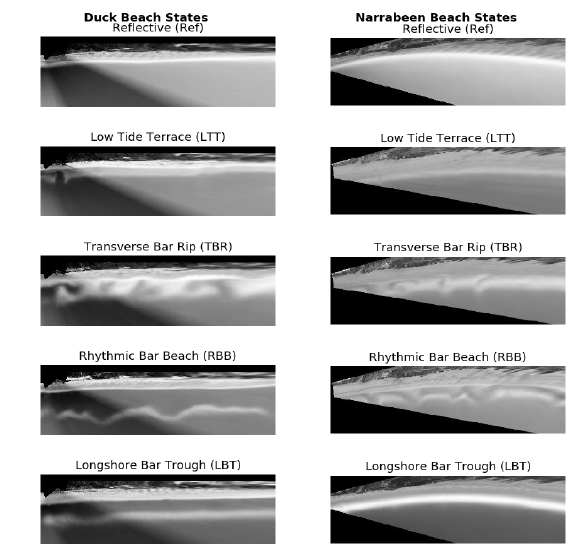
Figure 1. Examples of rectified Argus imagery from Duck ( left ) and Narrabeen ( right ), illustrating the Wright and Short classification scheme used for labelling. Note that the Duck imagery ( left ) is merged from multiple